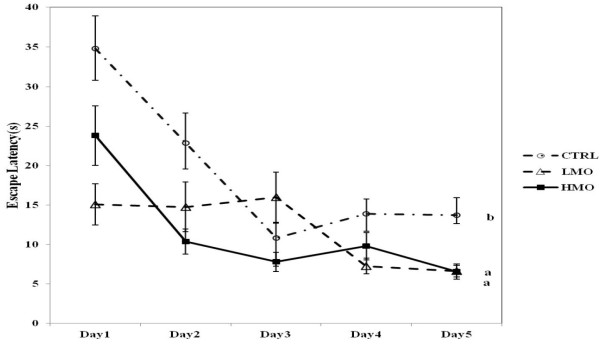
Escape latency over the training period (n = 10).a,b Lines with different alphabetic notation differ significantly at P < 0.0.5. CTRL, LMO and HMO refer to groups of rats fed with control, low menhaden oil, and high menhaden oil, respectively.